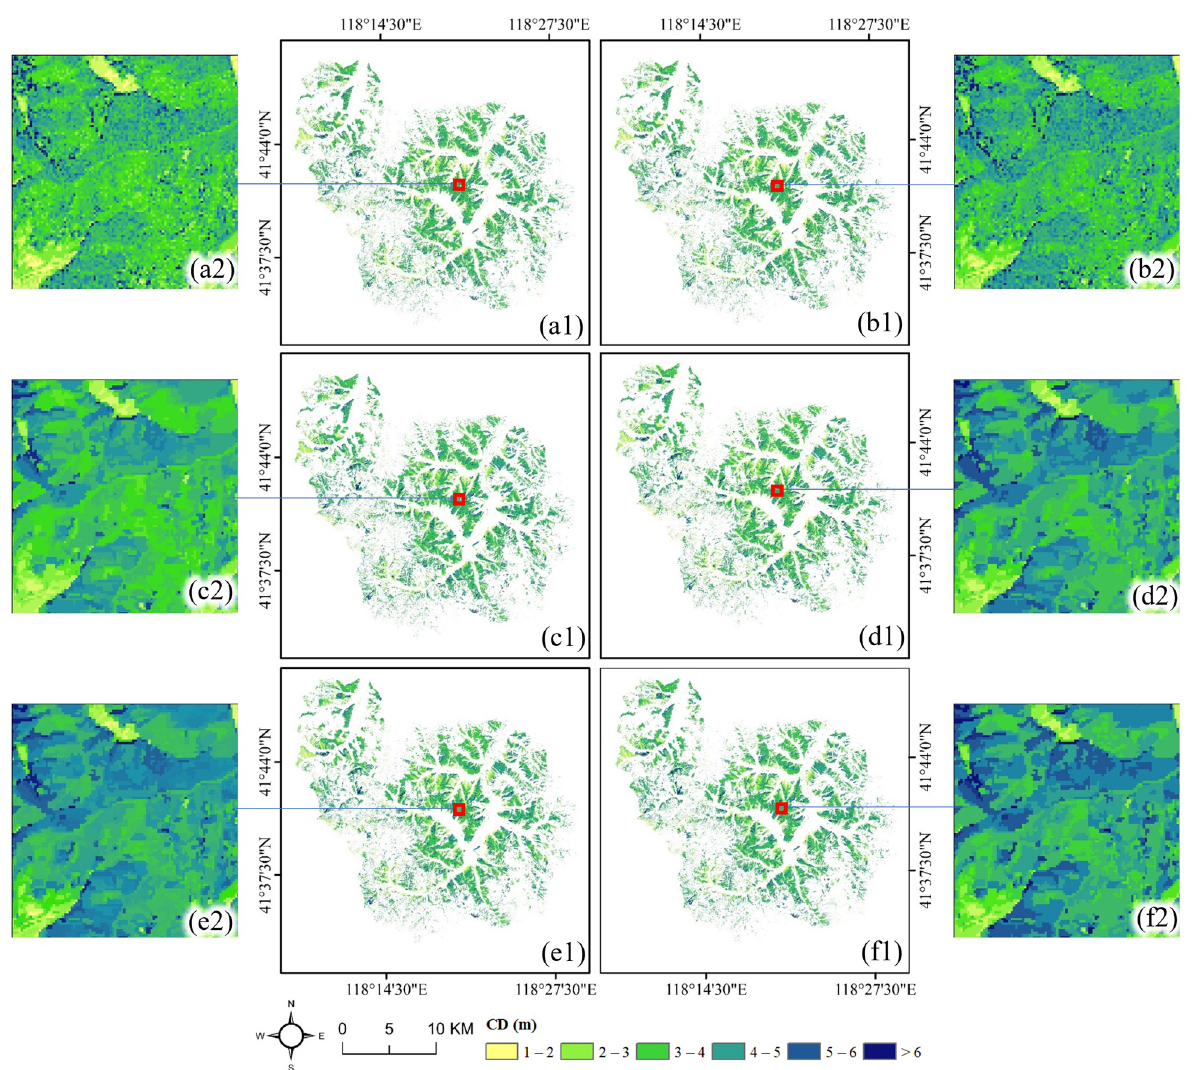
Figure 13. The maps of tree CD values using combined variable sets: ( a1 , b1 ) are combined variable sets (SFs + TFs and SFs + SH) with the fi lter-based method, respectively; ( c1 , d1 ) are combined vari- able sets (SFs + TFs and SFs + SH) with the object-based method, respectively; ( e1 , f1 ) are combined variable sets (SFs (object) and TFs ( fi lter) and SFs (object) and SH ( fi lter)) extracted with object-based and object-based metods, respectively; ( a2 – f2 ) are enlarged maps of corresponding local areas, re- spectively.